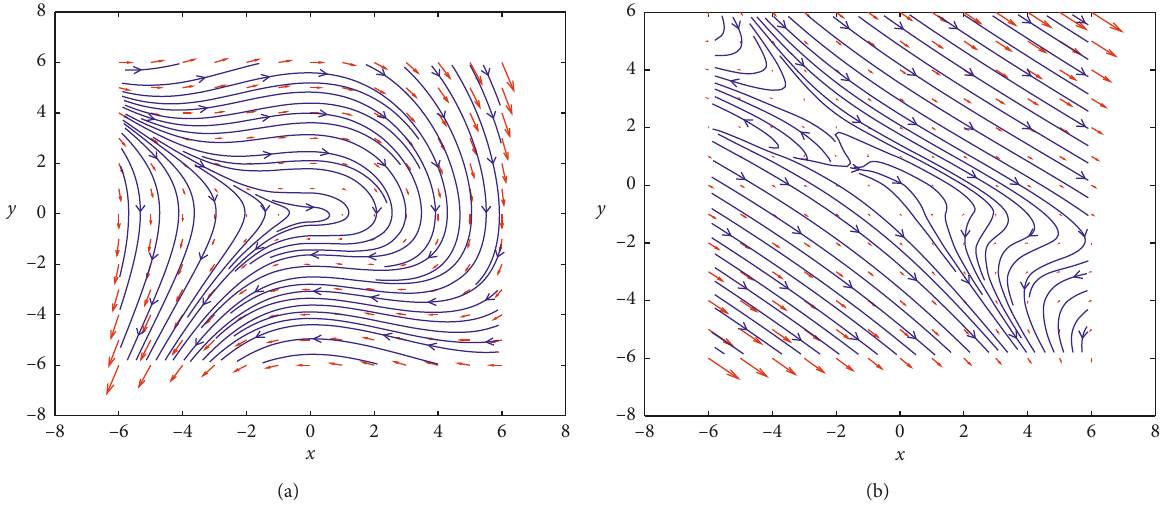
Figure 1: The vector fields for the transformation system of model (71) when u � Kr /4; here u � 4 ,K � 8, and r � 2. (a) The vector fields for the transformation system of model (71) for α � 1 � r /2; (b) the vector fields for the transformation system of model (71) for α � 0 . 6 ≠ r